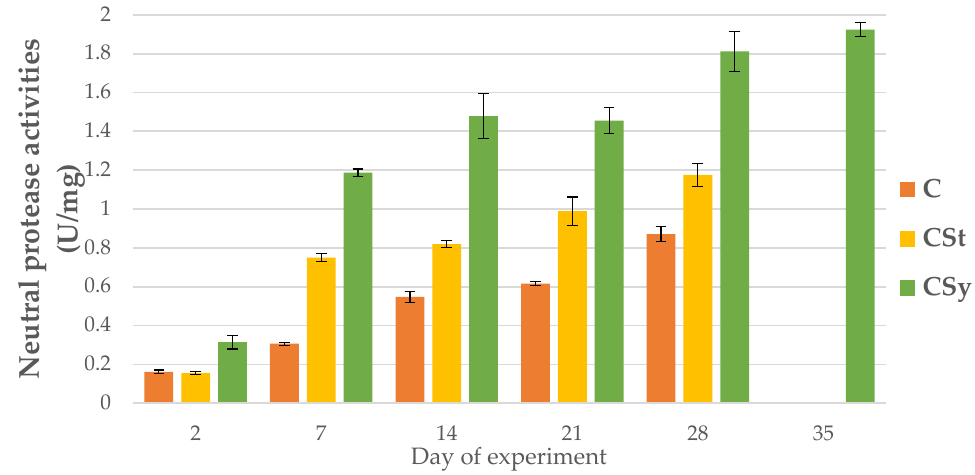
Figure 3. Neutral protease activities in the 2, 7, 14, 21, 28, 35-day-old honey bees’ hemolymph after two methods of supplementation with hemp extract: C-control (pure sugar syrup), CSy-hemp extract in syrup, CSt-hemp extract on strips (two-Way ANOVA) supplementa- tion method: F (2, 156) = 64.957, p = 0.0000, se ± 1.361555–0.500698 days of supplementation: F (4, 143) = 1754.7, p = 0.0000, se ± 0.009558–0.016555; supplementation method × days of supple- mentation F (8, 143) = 110.82, p = 0.0000, se ±